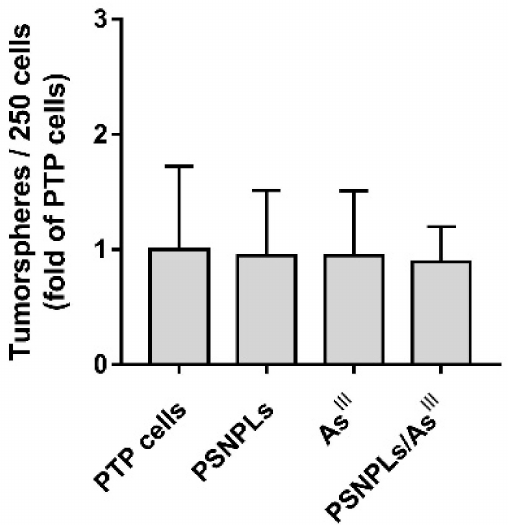
Figure 7. Evaluation of the proportion of stem-like cells in chronically (co)exposed cultures. Several tumorspheres formed for every 250 PTP cells seeded under tumorsphere-inducing conditions. Data are represented as fold of the mean comparing exposed PTP cells with the passage-matched PTP cells. Error bars represent